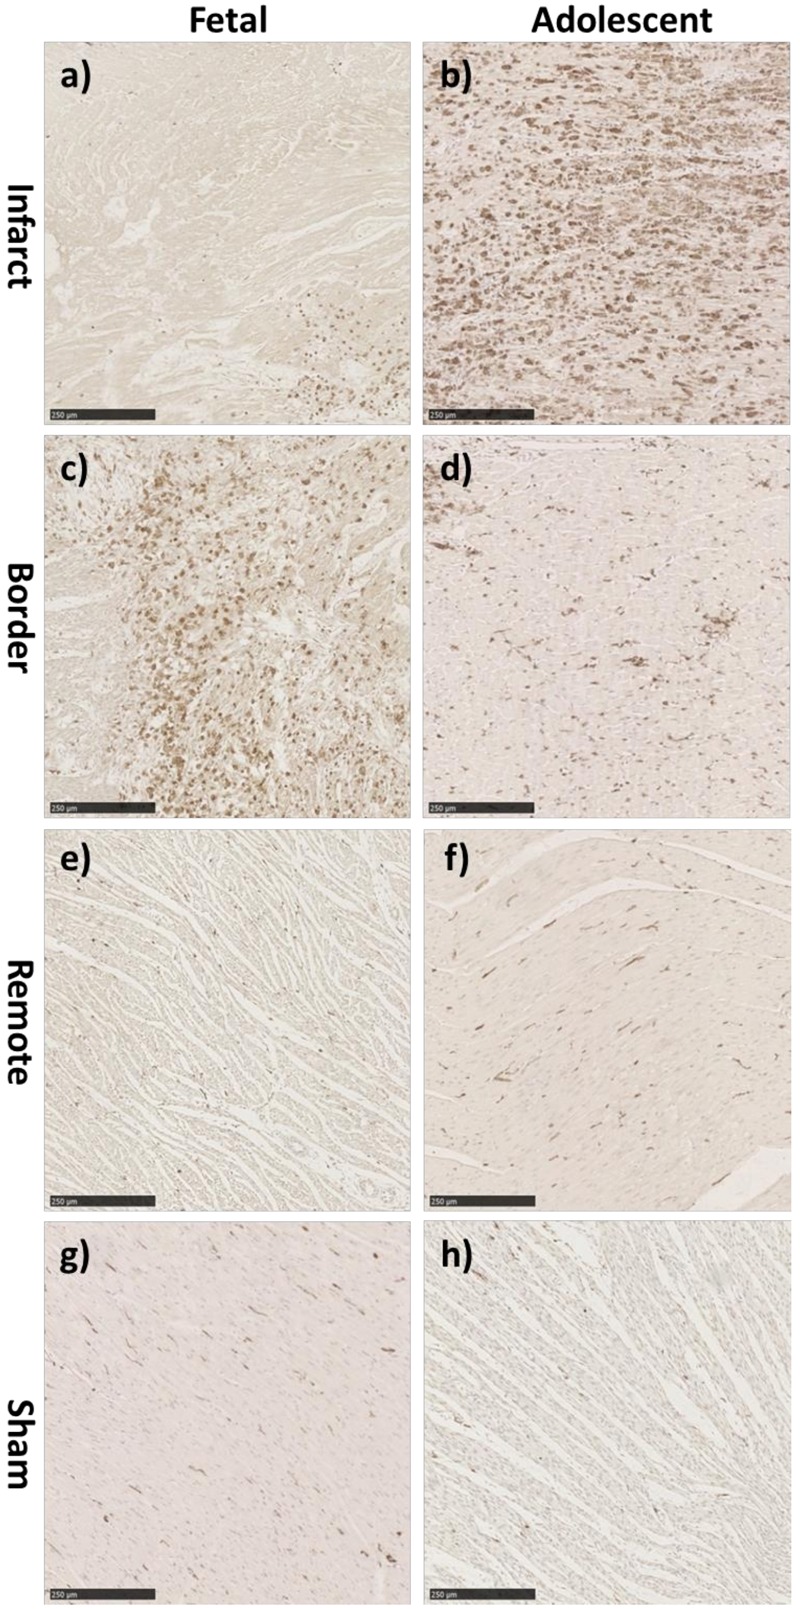
Representative IBA-1 immunohistochemistry staining in the fetus and adolescent sheep LV 3 days post-MI. (a) Fetal Infarct tissue, (c) fetal border zone tissue, (e) fetal remote zone tissue, and (g) fetal sham control tissue. (b) Adolescent sheep infarct tissue, (d) adolescent border zone tissue, (f) adolescent remote zone tissue, and (h) adolescent sham control tissue (20× Magnification). Scale bars = 250 μm.